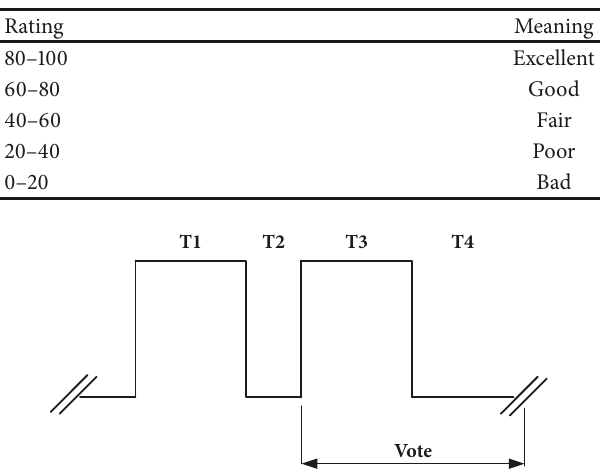
Figure 15: Timing diagram for stimulus presentation (variant